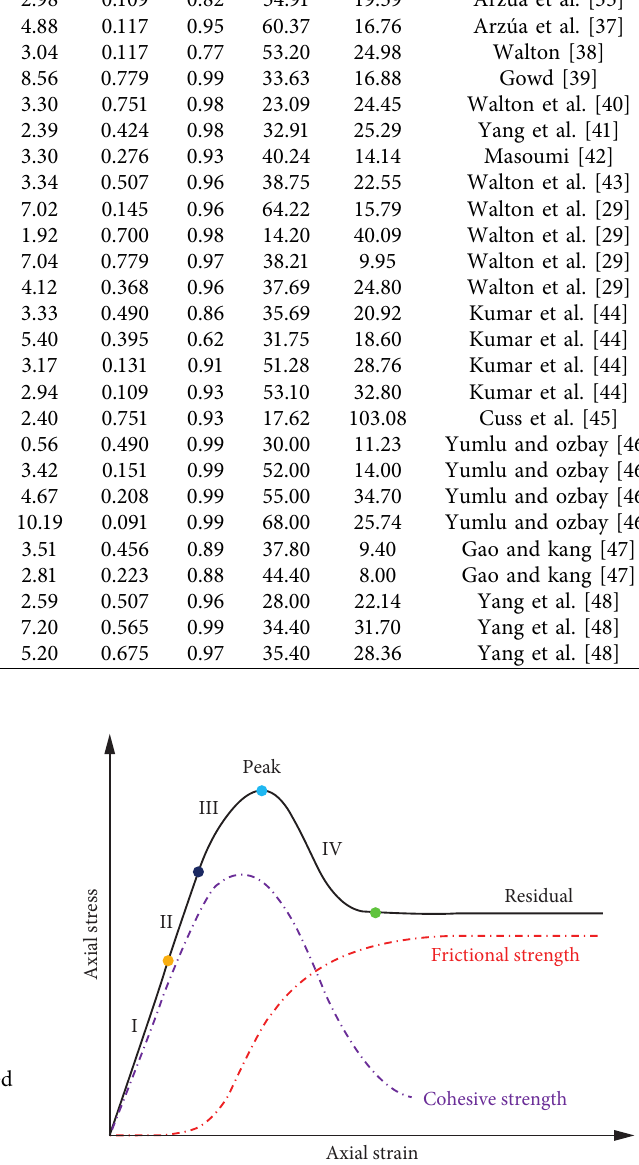
Figure 2: The frictional strength in the deformation process